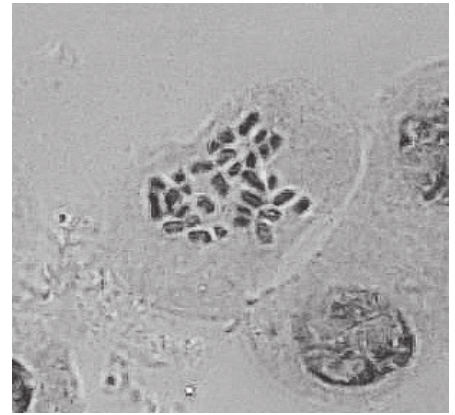
Figure 4. Mitotic metaphase chromosomes of Iris × ampliflora [number of chromosomes, 31]. each with 6–10 individuals in the population of I. × ampliflora , covering an area of 200 m 2 . Plants of I. × ampliflora grow well on roadsides of subtropical mixed evergreen deciduous broad-leaved forest in full-sun and partly-shaded environments at an